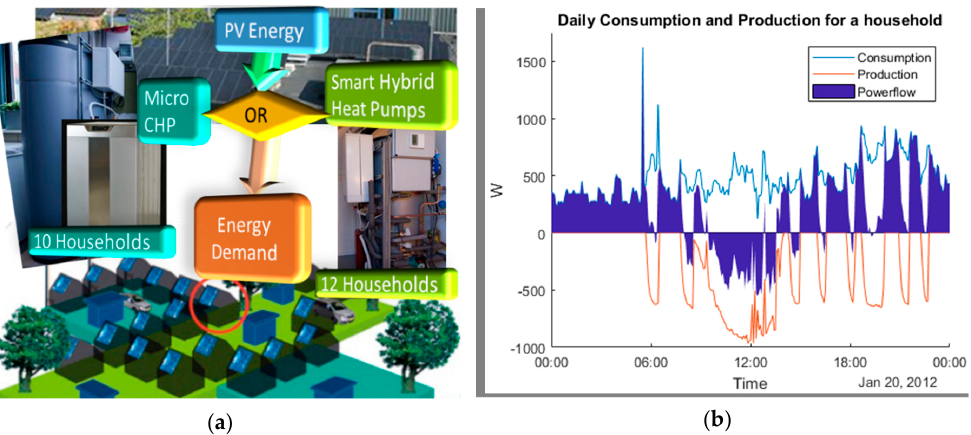
Figure 1. PowerMatching City: ( a ) scheme of the system, ( b ) energy consumption (blue line), energy production (red line), and power flow (blue area) for a household with photovoltaic (PV) systems and Micro-combined heat and power ( µ CHP) jointly producing energy, in the winter of 2012. Negative power flows indicate that power is fed to the grid.